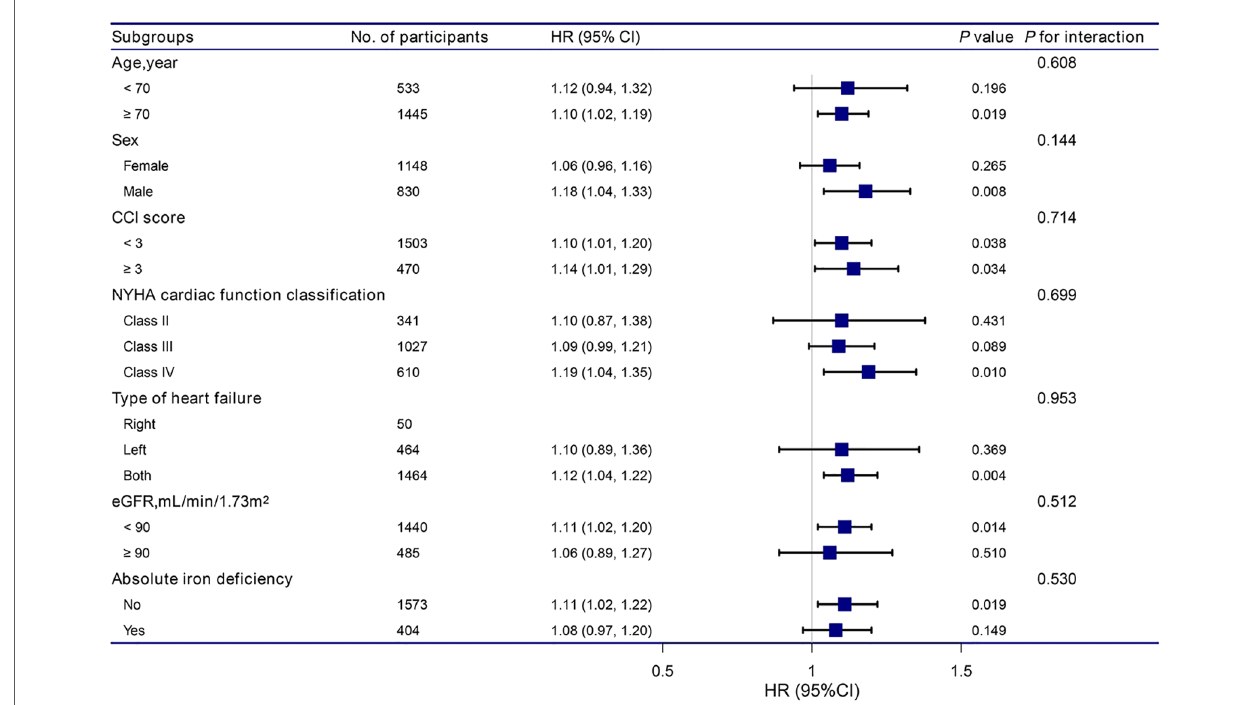
FIGURE 2 Association between RDW and the hazard ratio of readmission within 3 months according to subgroup. Analyses were adjusted for age, sex, BMI, CCI score, NYHA cardiac function classi fi cation, type of heart failure, BNP, RBC, HB, total protein, ALB, ALT, LDH, eGFR, and absolute ID, except for the strati fi cation variable. RDW, red cell distribution width; BMI, body mass index; CCI, charlson comorbidity index; NYHA, new york heart association; BNP, brain natriuretic peptide; RBC, red blood cell, HB, hemoglobin; ALB, albumin; ALT, alanine aminotransferase; LDH, lactate dehydrogenase; eGFR, estimated glomerular fi ltration